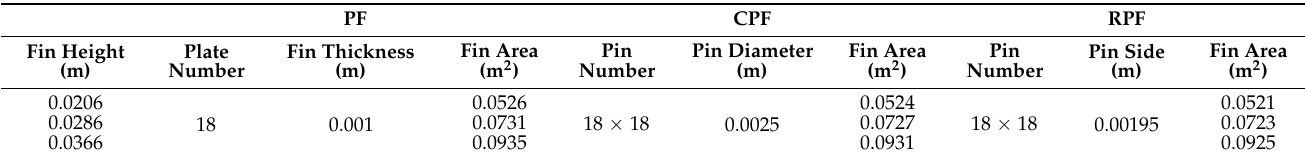
Figure 6. Comparison of pressure drops and thermal resistances of heat sink at different air veloci- ties using present model and results of previous studies. (Experimental data [31], CFD model [34]). The heat transfer characteristics of the solid components of the TEG module were validated by comparing the correlations between the hot- and cold-side temperatures of the module. During the industrial tests, the temperatures on the hot and cold sides of the TEG were measured for one module. Note that the heat transfer characteristics across the internal components of the TEG module were independent of the external boundary con- ditions. In the same system, the error of the cold-side temperature from the measurement and simulation data was verified by keeping the temperature on the hot side constant. Therefore, in the numerical simulations, the temperatures of the hot and cold sides of the TEG in 36 cases were determined and compared with the measurement data (Figure 7). The maximum variation between the measurement data and the simulation results was below 5%.